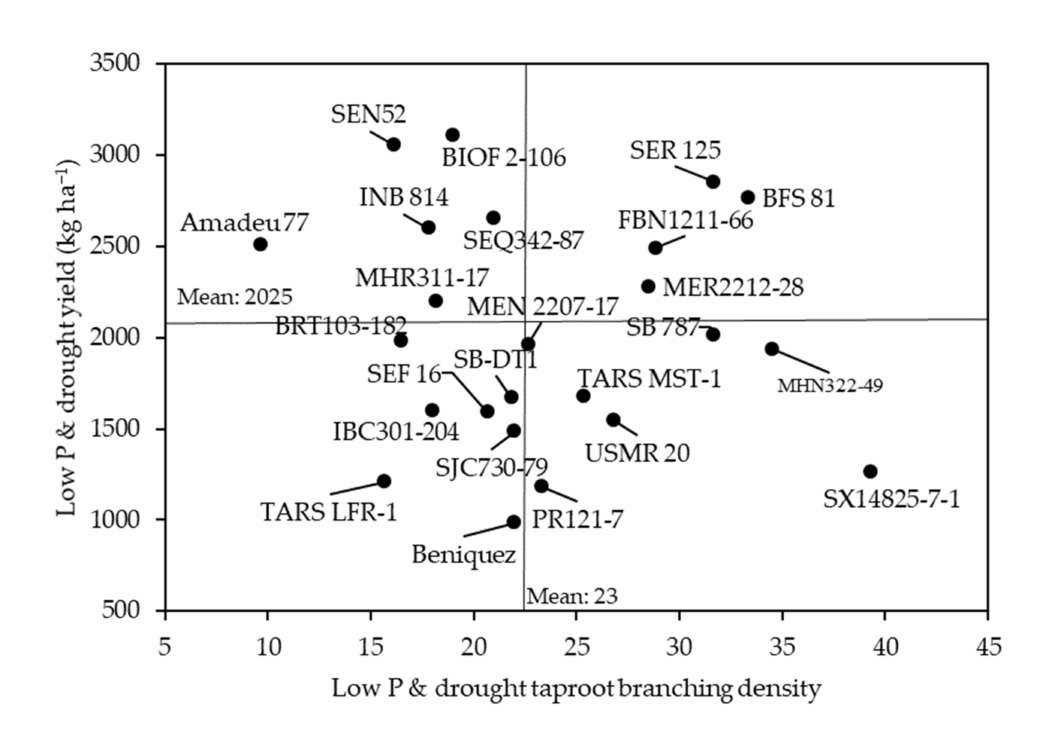
Figure 3. Identification of genotypes with superior yield and taproot branching density under low P and drought stress treatment. The outstanding genotypes with higher yield and greater taproot branching are in the upper right